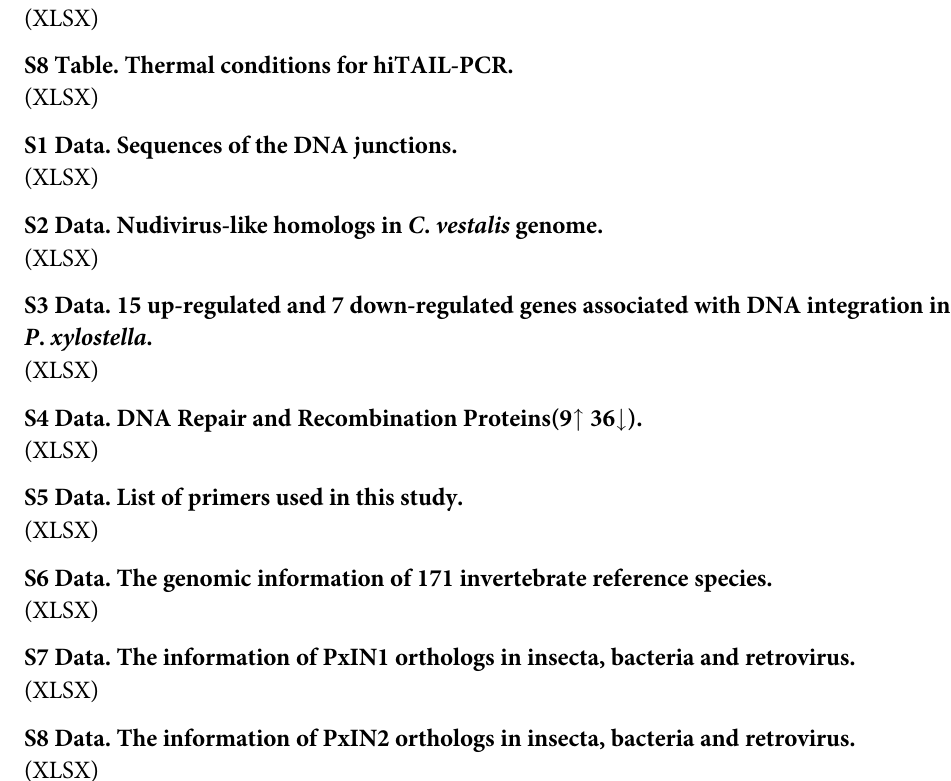
S7 Table. Standard curves of CvBV WIM copies. S8 Table. Thermal conditions for